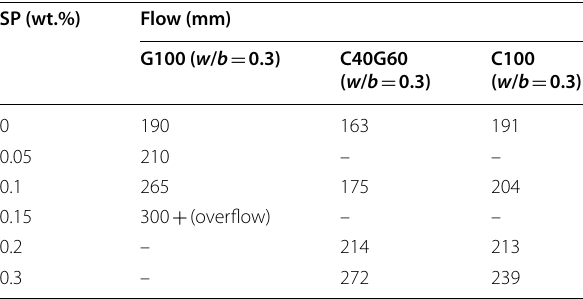
Table 3 Flow test results of fresh binders with different amounts of